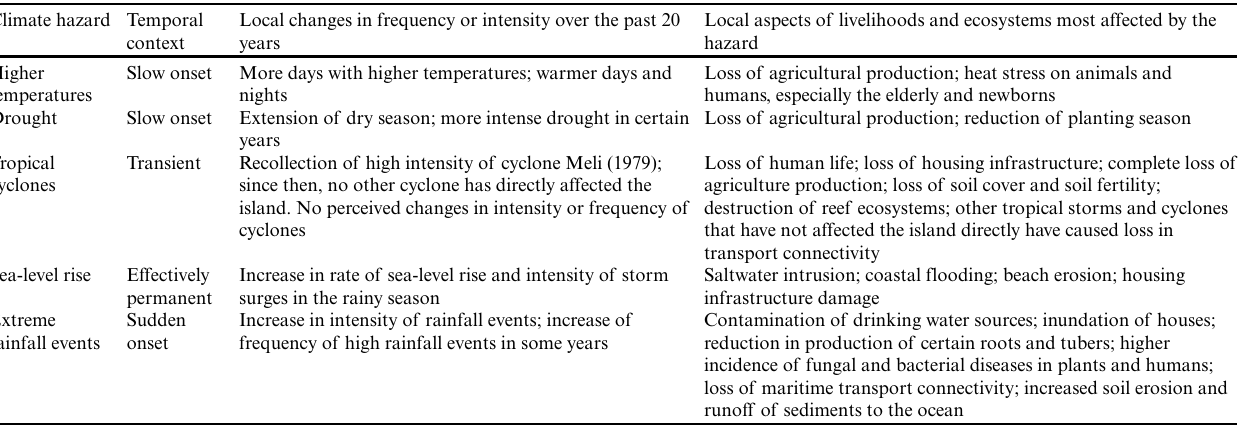
Table 1. Summary of observed changes in climate hazards and experienced impacts in Narikoso, Vabea, and Waisomo villages, Ono Island, Fiji, based on information from interviews with